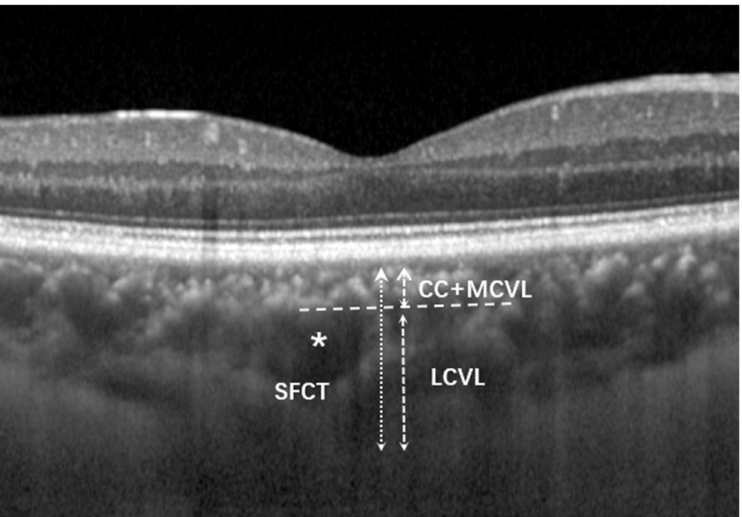
Figure 2. Thickness measurement of each vascular layer of the choroid in the healthy population. SFCT was measured at the fovea using the caliper of the OCT device. The asterisk (*) represents the large choroidal vessels (>100 µ m in diameter) that are labeled closest to the fovea. A horizontal line was plotted along the inner edge of the large choroidal vessels to intersect the line measuring the SFCT. The thickness of the LCVL was measured from the inner edge of the sclerochoroidal junction to the innermost point of the selected large choroidal vessel. The choriocapillaris–medium choroidal vessel layer (CC+MCVL) thickness, which is the distance from the outer edge of the highly reflective retinal pigment epithelium to the dashed line, measured by subtracting the LCVL thickness from SFCT.